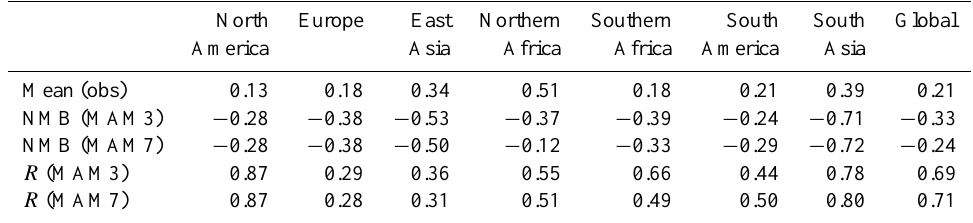
Table 9. Mean of observations (obs), and normalized mean bias (NMB) and correlation coefficients ( R) between model simulations and observations, for AOD over the seven regions in Fig. 24. The NMB is the difference between model and observed means divided by the observed mean. North Europe East